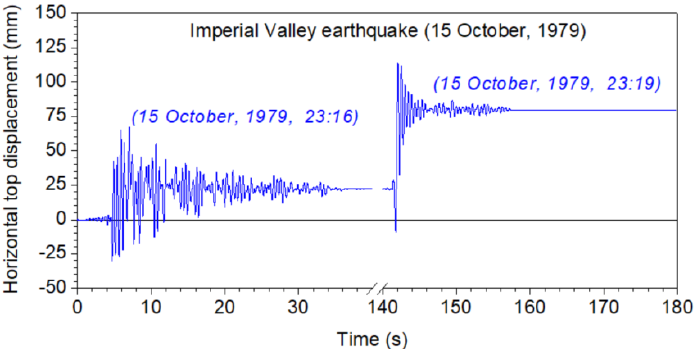
Figure 14. Fixed-base platform under the Imperial Valley earthquakes (15 October 1979, 23:16~23:19): time history of the horizontal top displacement.